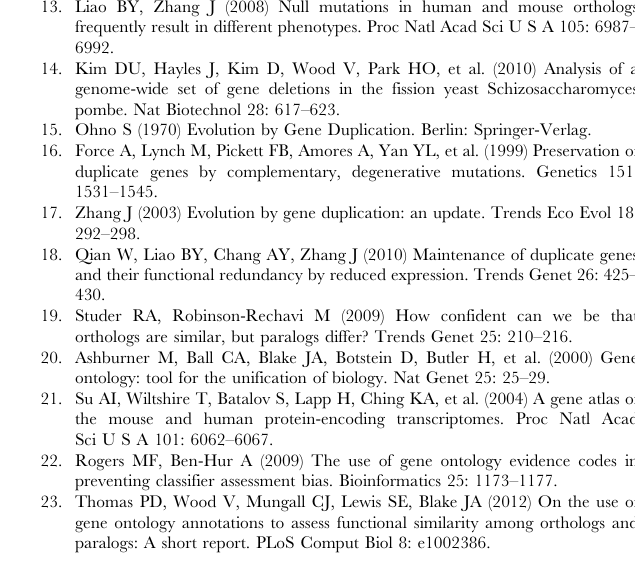
Figure S5 Variations of mean expression levels of orthologs, outparalogs, and inparalogs with different protein sequence identities. (PDF) Figure S6 Z -score-based expression similarity of homologous genes from multiple species, examined in nine tissues. Expression similarities of human inparalogs (green dots) are generally lower than those of orthologs between human and multiple species (red dots) for individual protein sequence identity bins in each of the nine tissues: (A) male brain, (B) male cerebellum, (C) male heart, (D) male kidney, (E) male testis, (F) female brain, (G) female cerebellum, (H) female heart, and (I) female kidney. Mean expression similarity of human inparalogs (green bar) and those of orthologs between human and multiple species (red bars) in each of the nine tissues: (J) male brain, (K) male cerebellum, (L) male heart, (M) male kidney, (N) male testis, (O) female brain, (P) female cerebellum, (Q) female heart, and (R) female kidney. For all panels, error bars indicate one standard error. Expression data from certain tissues are not available in some species. Figure S7 Rank-based expression similarity of homologous genes from multiple species, examined in nine tissues. Expression similarities of human inparalogs (green dots) are generally lower than those of orthologs between human and multiple species (red dots) for individual protein sequence identity bins in each of the nine tissues: (A) male brain, (B) male cerebellum, (C) male heart, (D) male kidney, (E) male testis, (F) female brain, (G) female cerebellum, (H) female heart, and (I) female kidney. Mean expression similarity of human inparalogs (green bar) and those of orthologs between human and multiple species (red bars) in each of the nine tissues: (J) male brain, (K) male cerebellum, (L) male heart, (M) male kidney, (N) male testis, (O) female brain, (P) female cerebellum, (Q) female heart, and (R) female kidney. For all panels, error bars indicate one standard error. Expression data from certain tissues are not available in some species.